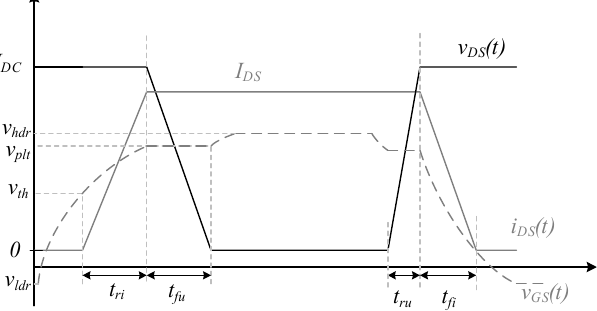
Figure 2. Simplified depiction of the turn-ON and turn-OFF process of a MOSFET device assuming constant derivatives for the channel current and the device drain to source